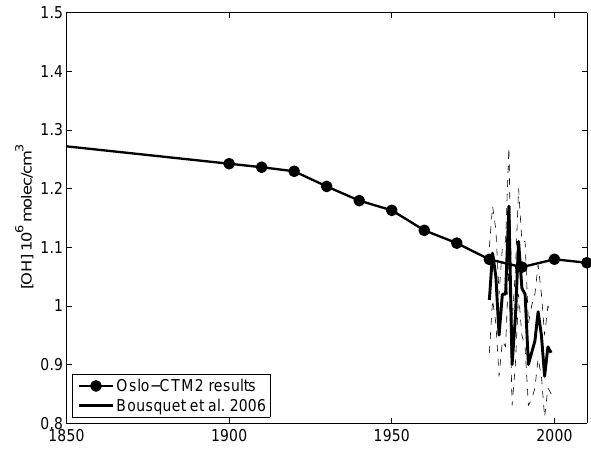
Fig. 8. Modelled annual mean global OH concentration (black dots) Figure 8: Modelled annual mean global OH concentration (black dots) and de- and derived OH concentrations (solid line) with uncertainties (dot- ted lines) from Bousquet et al. rived OH concentrations (solid line) with uncertainties (dotted lines) from Bous- quet et al. (2006).